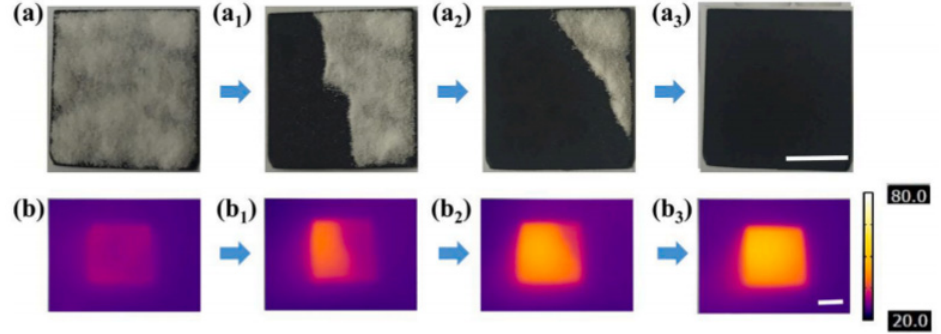
Figure 7. ( а – а 3 ) Self-cleaning test of superhydrophobic photothermal coating; ( b – b 3 ) thermograms of surfaces corresponding to ( a – a 3 ) after one irradiation process. Reprinted with permission from [43].